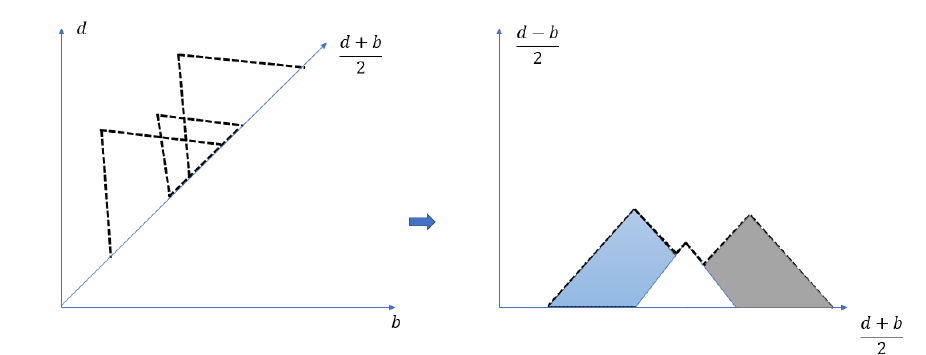
Figure 4. A visual example of the transformation of a persistence diagram representation (PDR) into a persistence landscape (PL). The horizontal axis represents birth time, while the vertical axis represents death time on the persistence diagram ( left ). The horizontal axis is the average of the homologies of the birth and death times, and the vertical axis is used for ( d − b ) /2 on the persistence landscape ( right ).